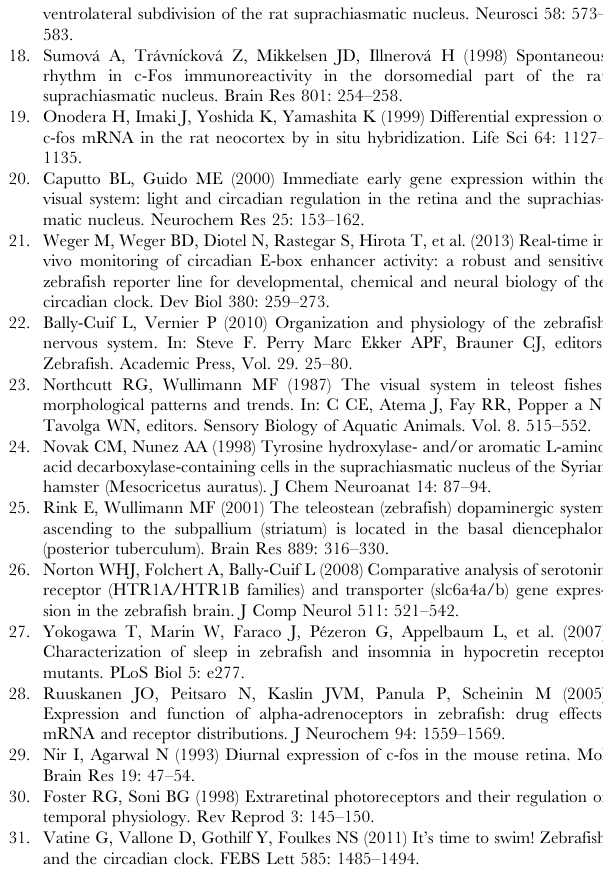
Figure S1 Sense controls for brain in situ hybridization experiments. The panels in this figure show in situ hybridization results for brain sections stained with the sense control probes for